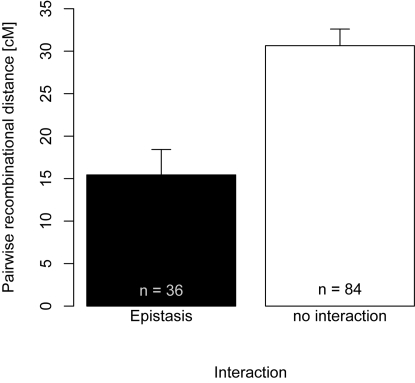
Average recombination distance between of pairs of polymorphic immune genes on chromosome 2 of D. melanogaster.
Recombination rate (mean±SE) was significantly lower between epistatically interacting genes than between genes that did not show an interaction. Pairs were grouped according to the epistatic interaction between both genes as defined in Lazzaro et. al. [17]. The number of pairs is given in the bottom of each bar.